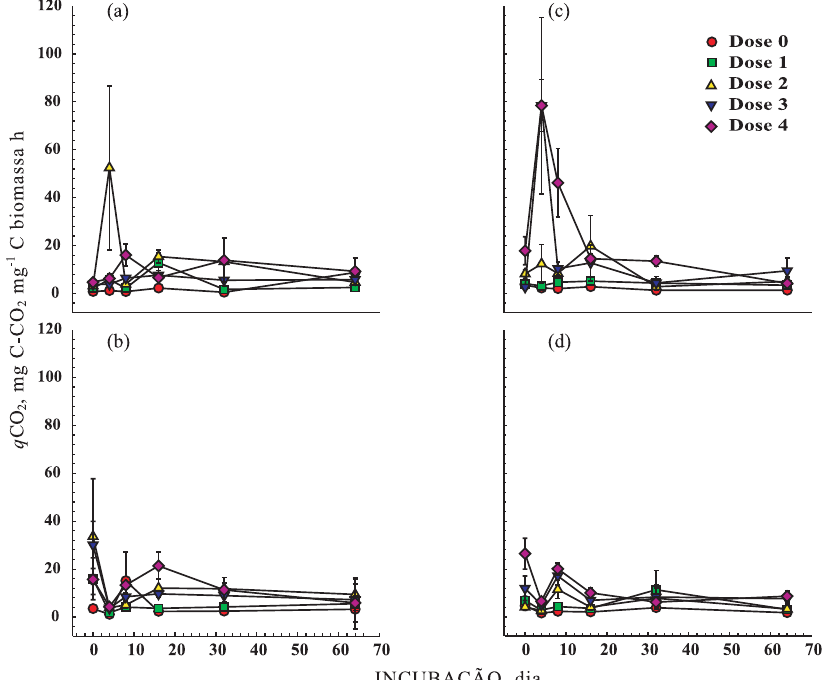
Figura 3. Variação do quociente metabólico ( q CO biossólidos da ETE-Barueri (a, b) ou ETE-Franca (c, d). Os dados são médias de 3 repetições ± desvio- padrão da